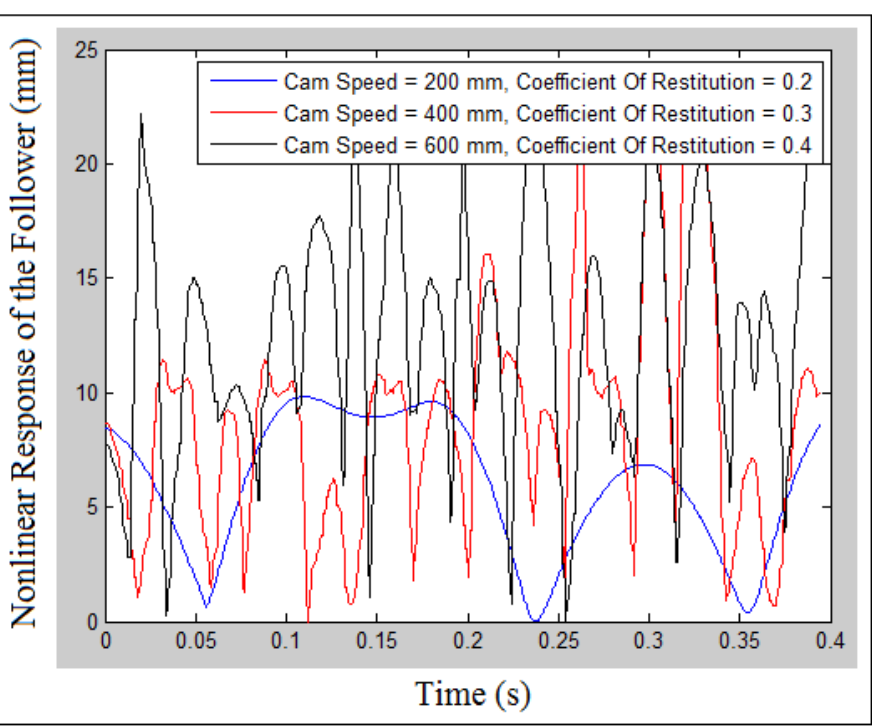
Figure 7. Nonlinear response when the follower offsets to the right at (O = 10 mm) and follower guide’s clearance (16 mm).